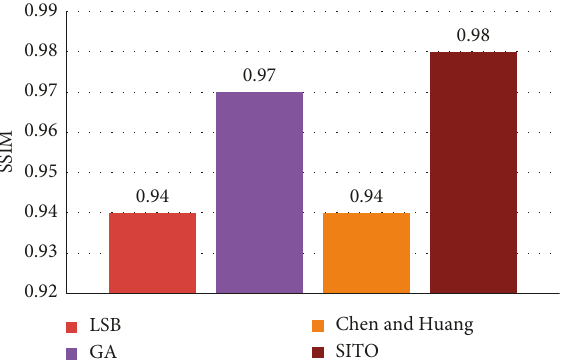
Figure 12: SSIM attainment.